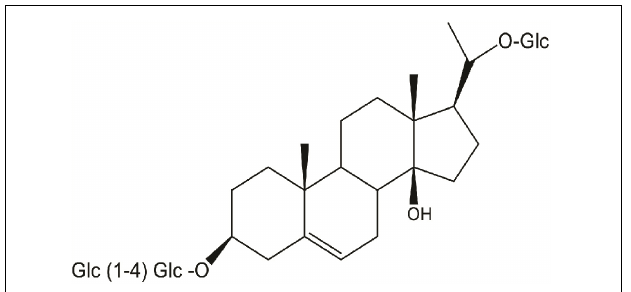
FIGURE 1 | Chemical structure of russelioside